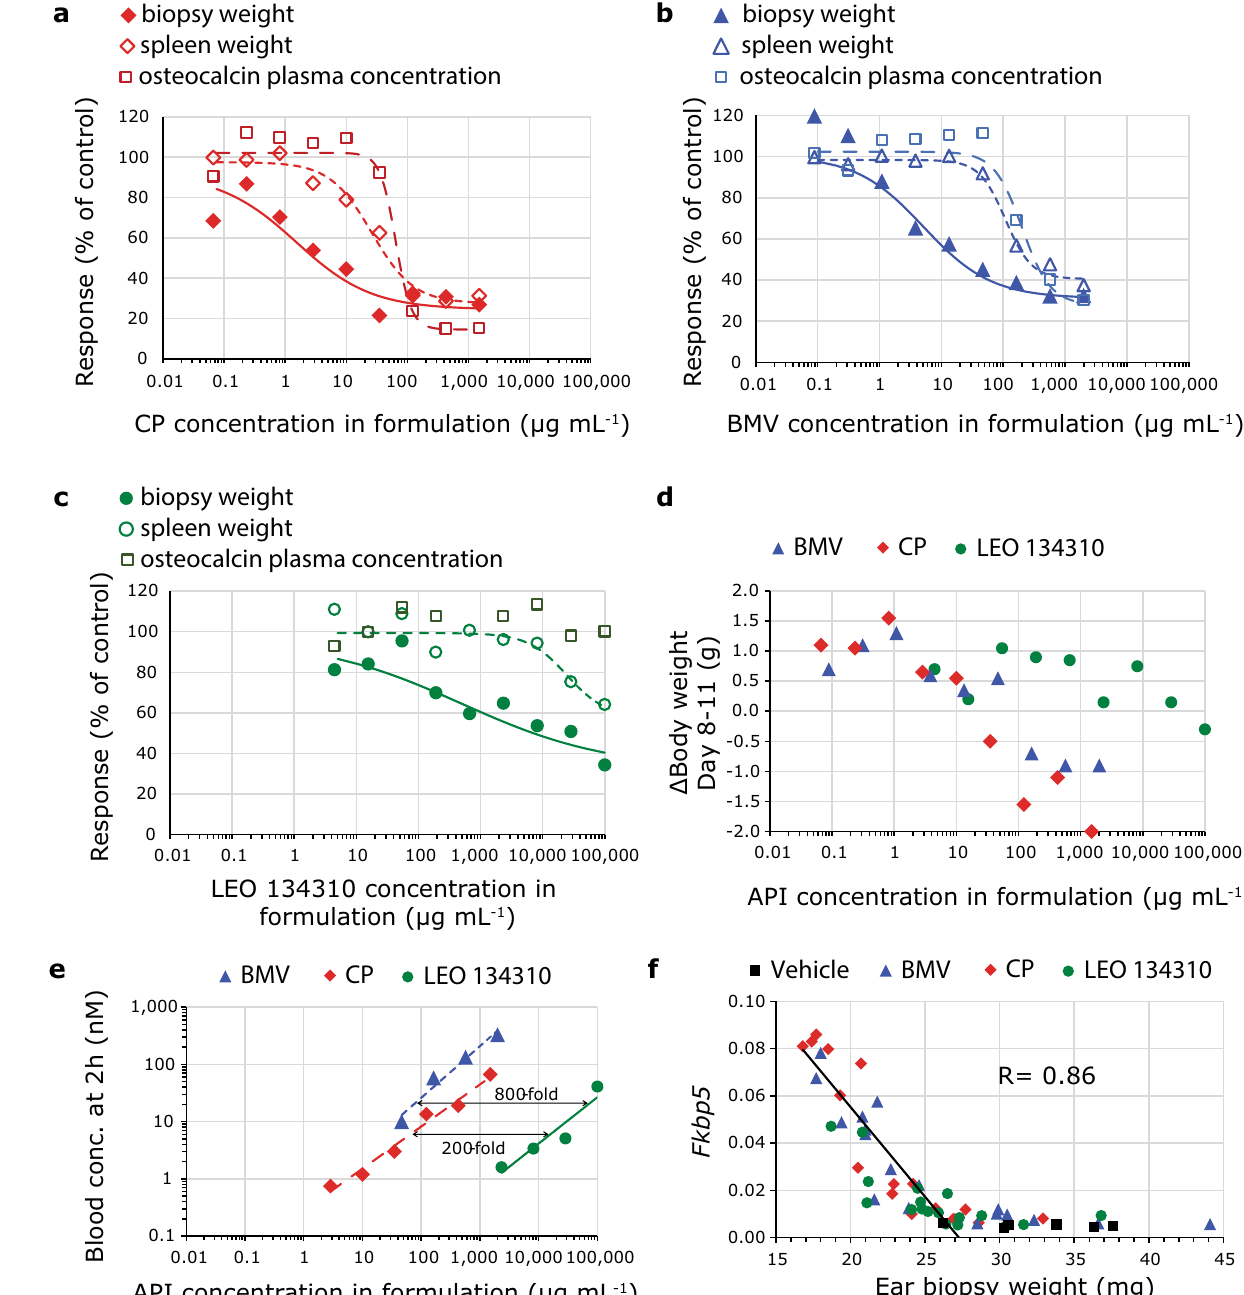
Figure 3. In vivo efficacy versus systemic side effects of LEO 134310, CP and BMV in the TPA-induced skin inflammation mouse model. Dose–response curves for effect of CP ( a ), BMV ( b ) and LEO 134310 ( c ) on ear biopsy weight, spleen weight and osteocalcin plasma concentration in the TPA mouse model. All values are normalized to vehicle/TPA controls. Body weight vs. dose ( d ), blood concentration at 2 h after dosing vs. dose ( e ) and mRNA levels of Fkbp5 vs ear biopsy weight ( f ) (R = correlation coefficient). Vehicle, ( a ) CP, ( b ) BMV, ( c ) LEO 134310. Mean values at each dose (n = 2) in ( a – e ) and individual values in ( f